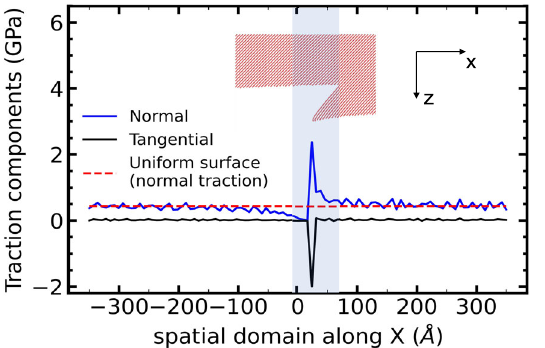
FIG. 3. Effect of surface slip height growth on the field- enhanced peak traction values normalized by E 2 . Circles refer to QEq-MD simulation results, whereas the dotted lines indicate fitting to Eq. (1). Continuum large-step limits are depicted by solid